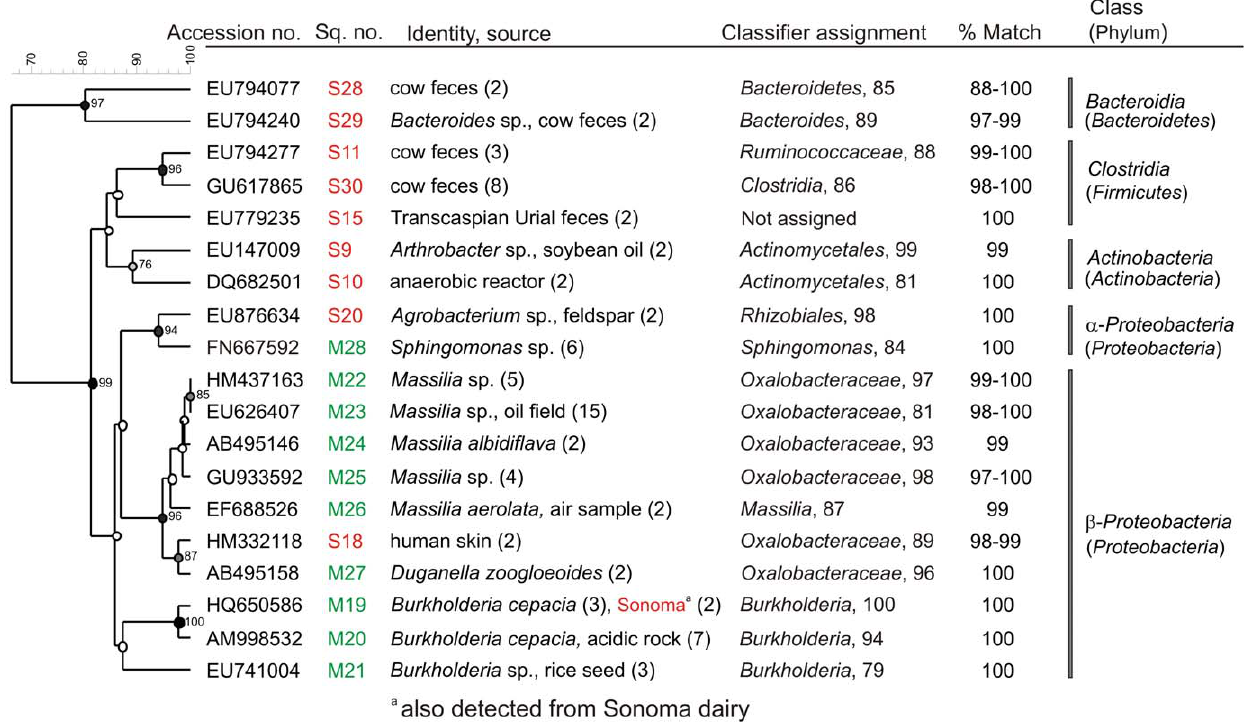
Figure 6. Phylogenetic relationship of the 10 abundant sequences characterized from aerosol samples collected from two different dairies. Identity or the original source of uncultured bacteria and the accession numbers are given. Sequence numbers (Sq no.) are GenBank identifiers for sequences from Sonoma dairy (S) and Modesto dairy (M). Numbers in parenthesis following the source are number of clones characterized for the sequence. Bootstrap values . 70% are noted at each node. Classifier assignment to the hierarchial taxa along with percent reliability values are given.